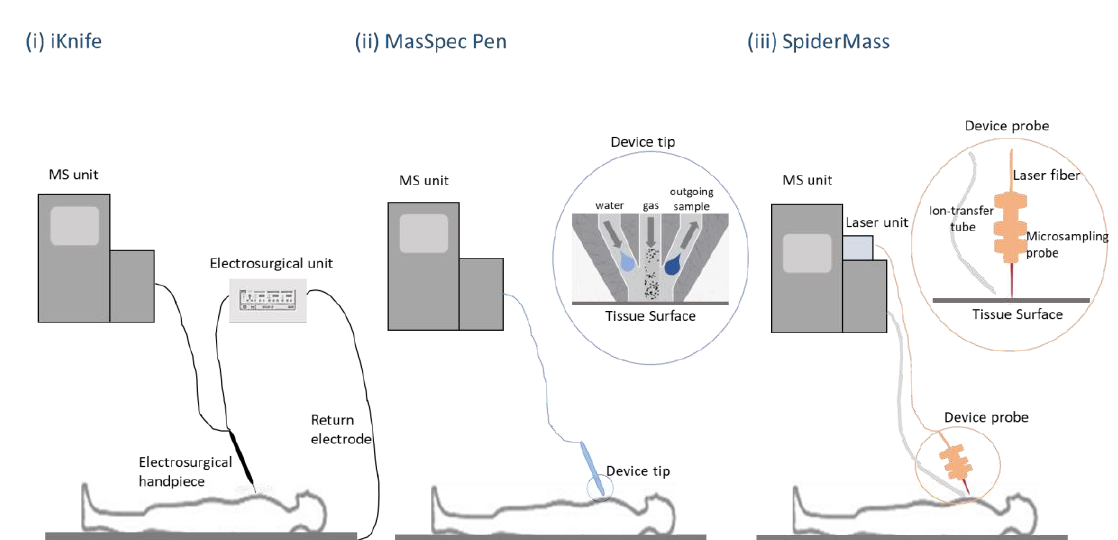
Figure 3. Schematic representation of iKnife, MasSpec Pen, and SpiderMass. ( i ) The Iknife, is known as the intelligent surgical knife that distinguishes normal to malignant tissues. The handpiece delivers aerosols from the electrocauterization to the MS unit for molecular analysis. ( ii ) When the MasSpec Pen is activated, a discrete volume water droplet is exported by the first conduit and interacts with the tissue surface. After 3 s, the gas and vacuum conduits open to transport the droplet with the extracted molecules to the MS unit for molecular analysis. ( iii ) The SpiderMass analysis is performed through a fiber laser microsampling device. The ion transfer tube collects aerosols and transports them to the MS unit.